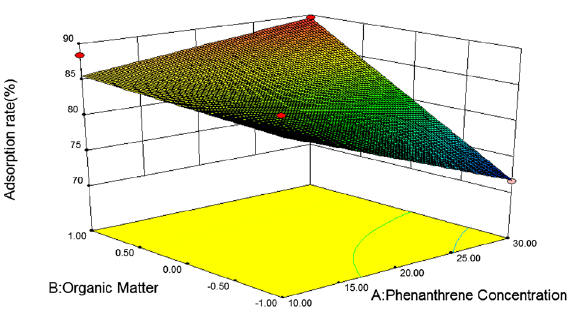
Figure 6. Effects of initial phenanthrene concentration and organic matter on the adsorption rate of